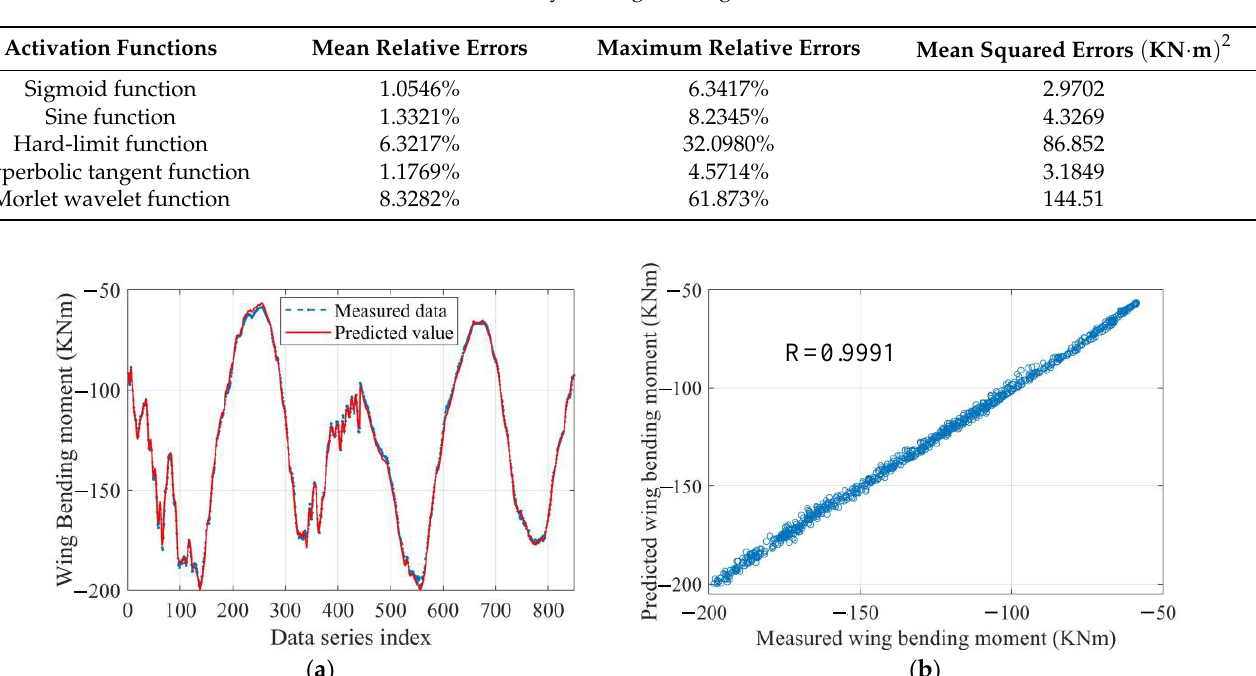
Figure 8. Wing bending moment prediction based on ELM ( φ : sigmoid function; K = 100): ( a ) predicted value series; ( b ) the correlation coefficient between measured and predicted values.